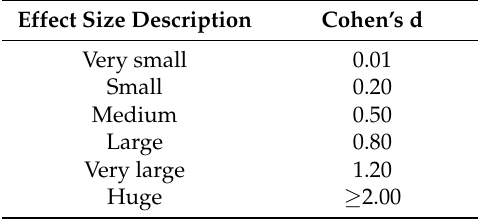
Table 3. The magnitude descriptors of Cohen’s d effect size